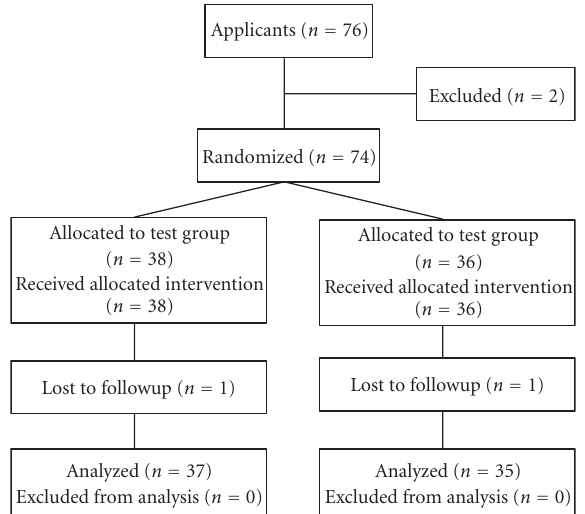
Figure 1: Flowchart of participants through each stage of the randomized